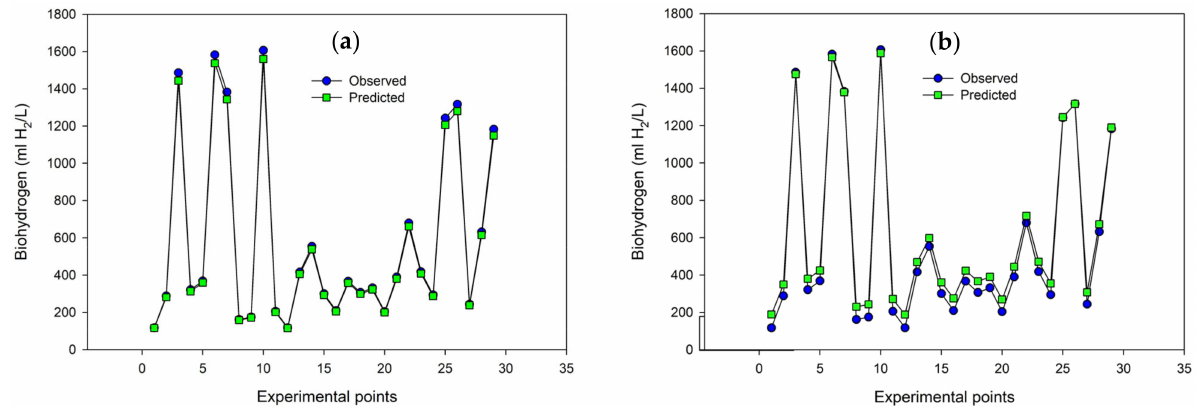
Figure 4. Comparison between the actual and predicted biohydrogen using ( a ) RBFNN-1 ( b )